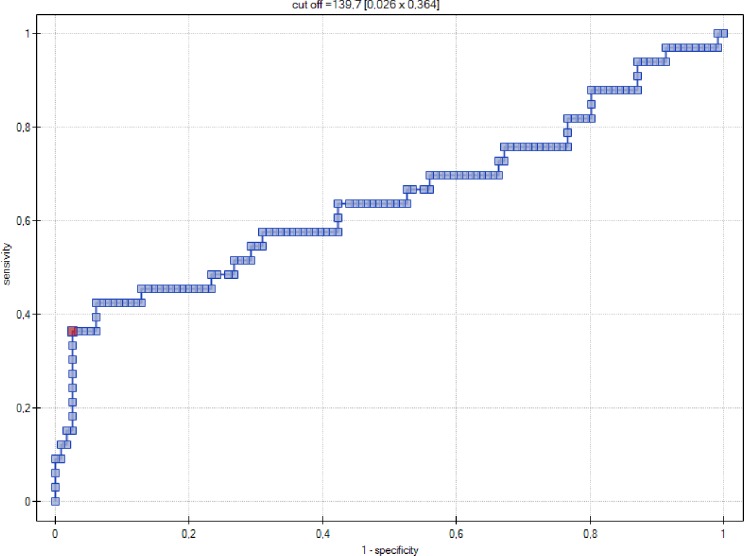
ROC curve–relationship between NT-proBNP levels (pg/ml) and occurrence of gestational hypertension.